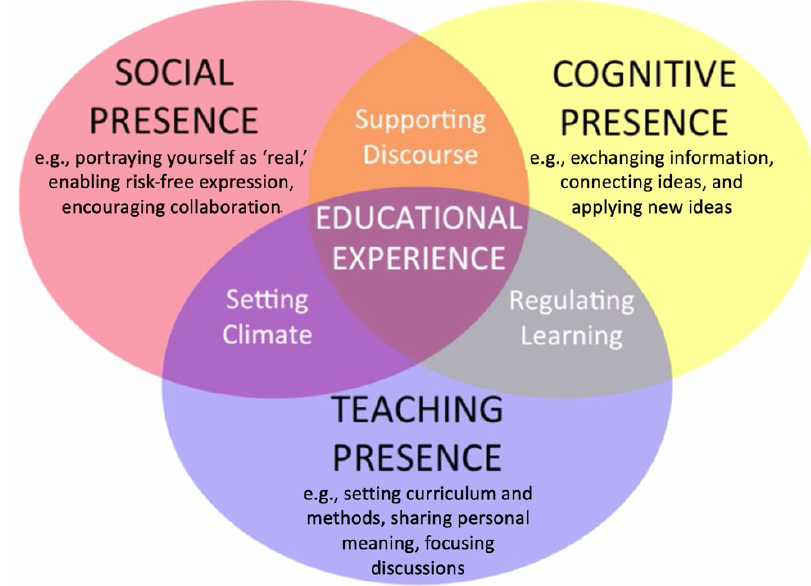
Model for Community of Inquiry